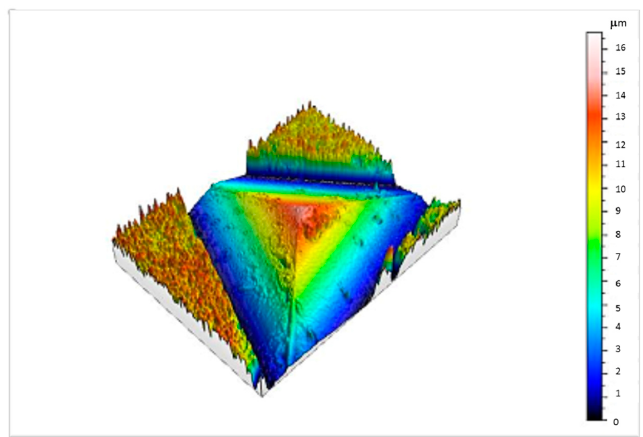
Figure 1. Berkovich indenter tip analyzed by optical profilometer to check the rounding and wear of the very tip.